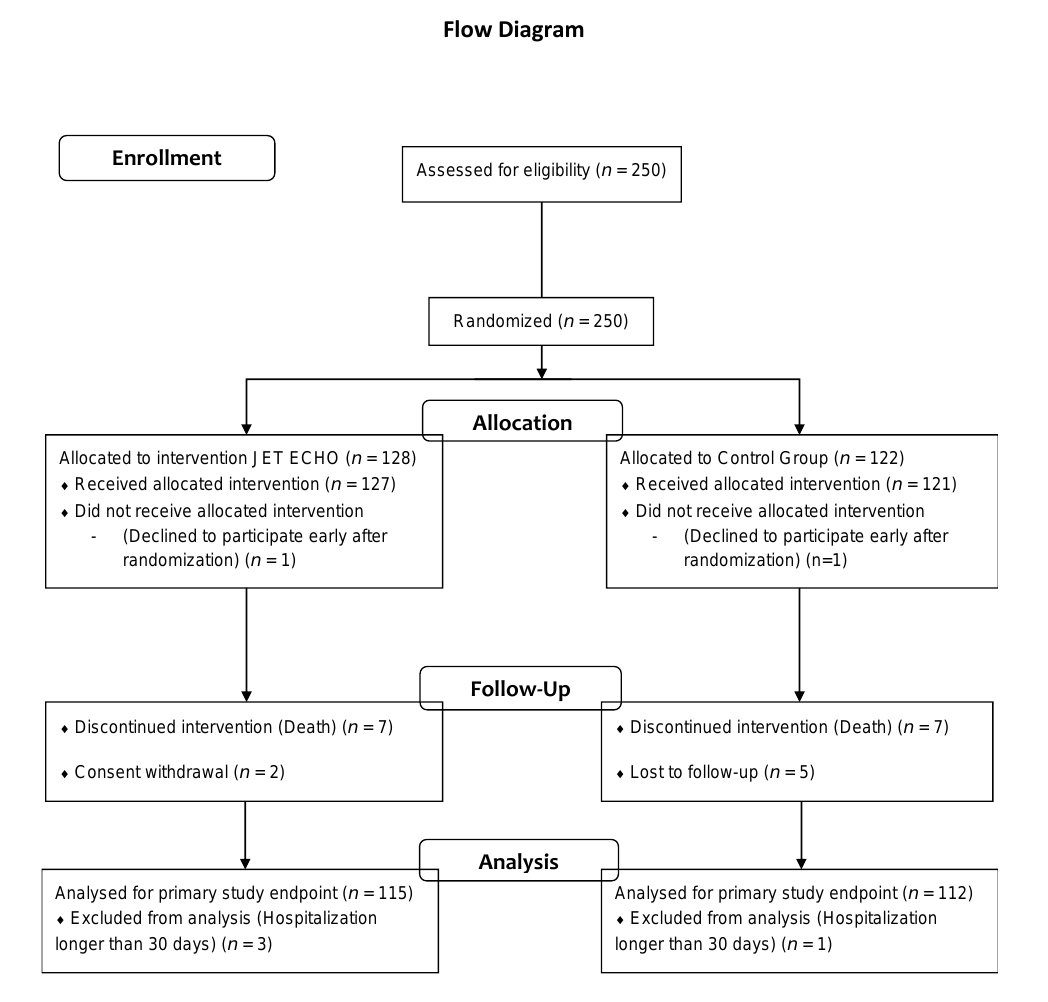
Figure 1. Study Flow Chart.